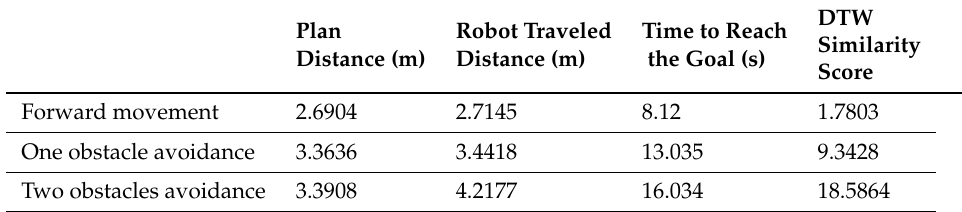
Table 14. Navigation experiments